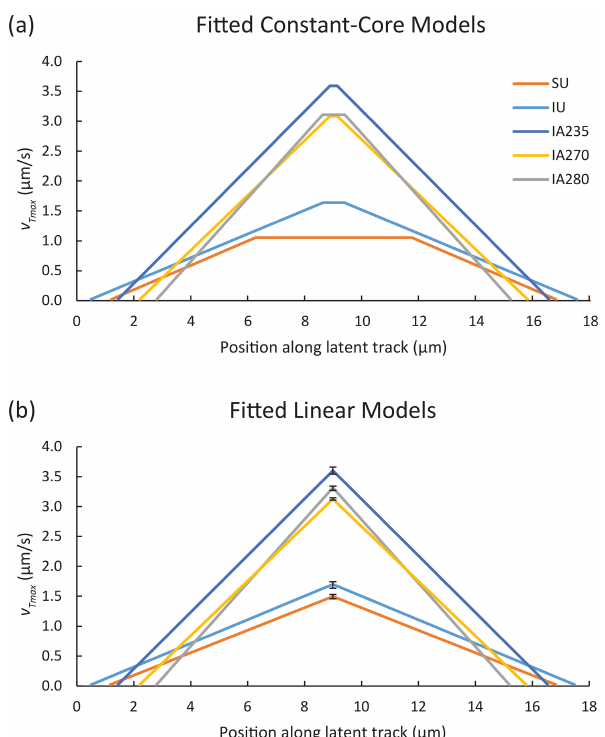
Figure 15. Best-fit results for (a) constant-core and (b) linear etch- ing structure models, showing that laboratory-annealed experiments feature maximum etching velocities ∼ 2 times higher than tracks without heat treatment. Error bars are only shown for the maximum etching velocity in the linear models owing to the complex corre- lation between maximum velocity and core length in the constant- core ones (Fig.